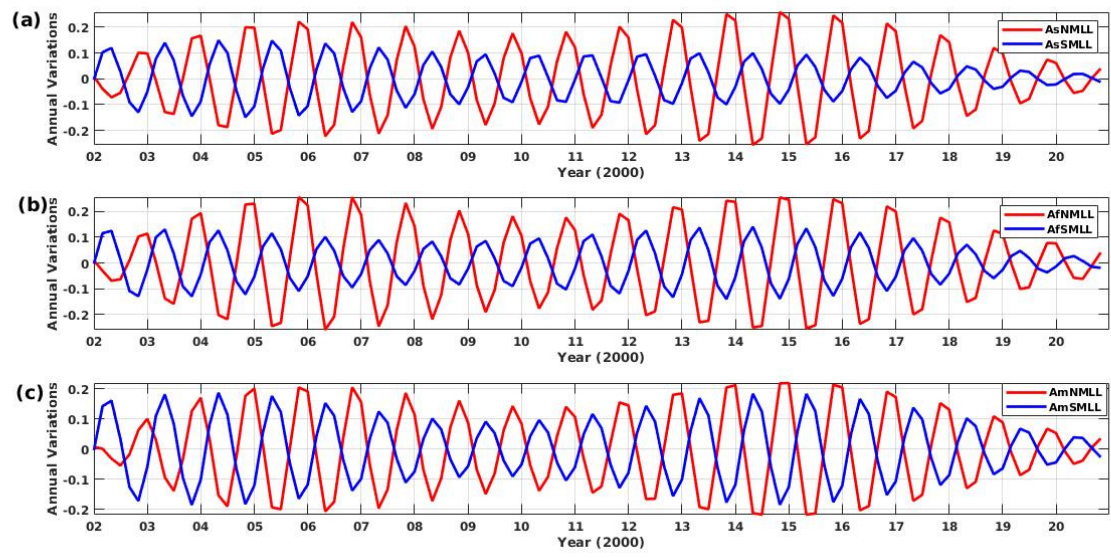
Figure 8. Similar to Figure 2b but for the sectors of ( a ) Asia, ( b ) Africa, and ( c ) America.